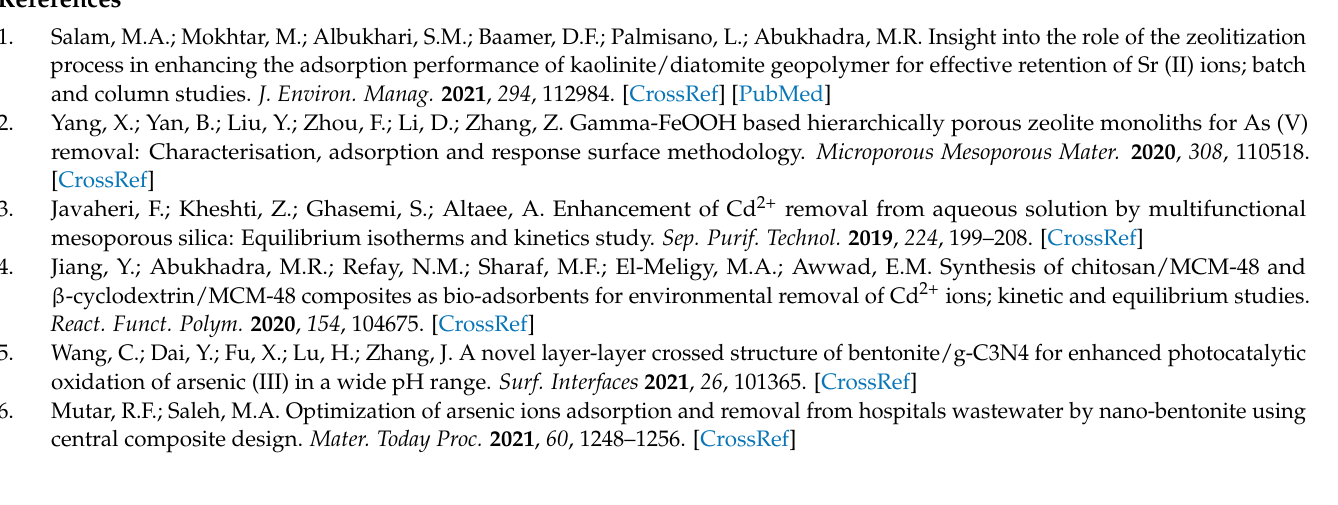
green composite; Figure S2: Recyclability of G.Zn@PN/BE during the retention of As (V) ions from water; Table S1. Nonlinear equations of kinetic, classic isotherm, and advanced isotherm